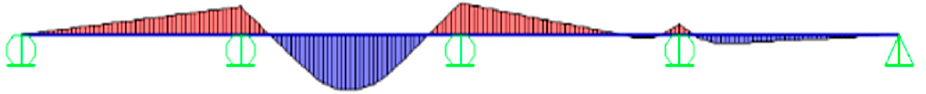
Figure 13. Moment diagram for the entire beam [10].